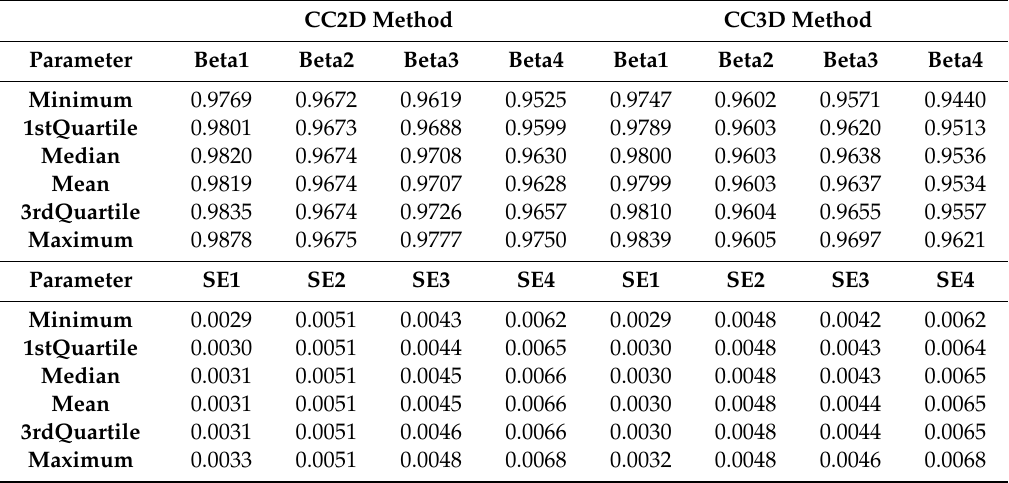
Table 1. Estimated parameters obtained for the CC2D and CC3D methods.